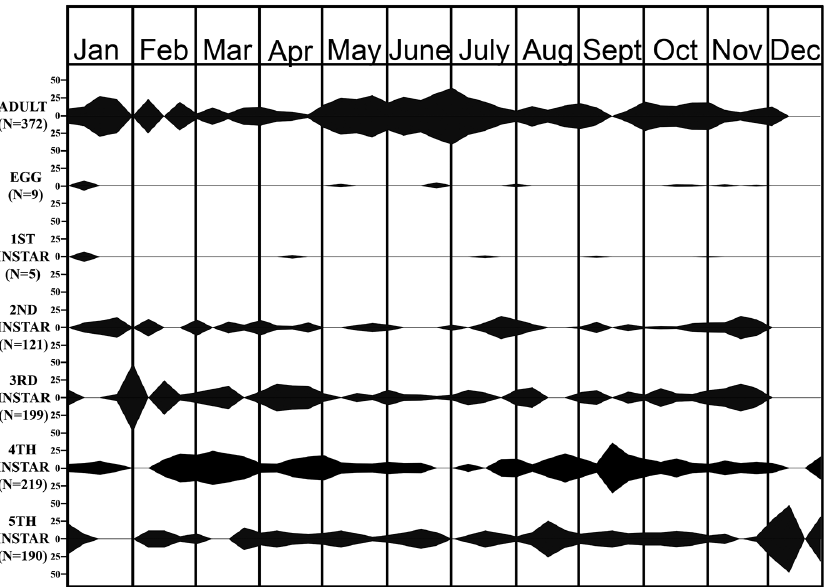
Figure 1. Field life cycle of M. major . Percentage in each sample of individuals of each stage collected during 2005-2007 in Las Cruces, NM. Beginning and end points of each shaded area represent sample dates preceding and following collections of specimens, respectively.